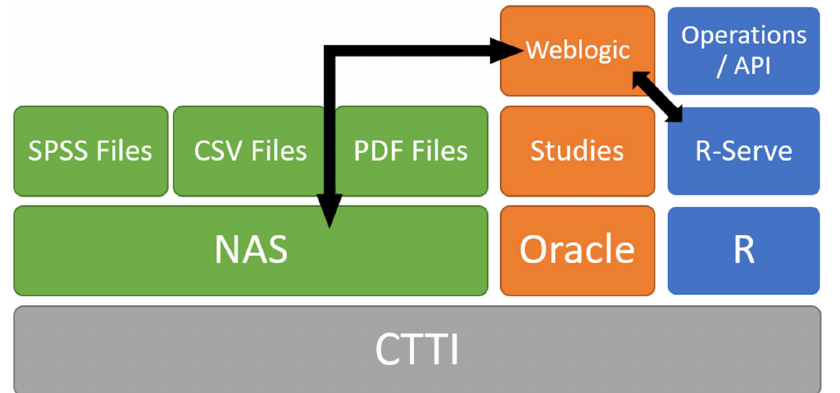
Figure 4. System structure for the current implementation of the proposal. The communication between the different subsystems is done mainly through the network attached storage (NAS), Weblogic and R-Serve packages that primarily serve as matrix, questions and operations managers.